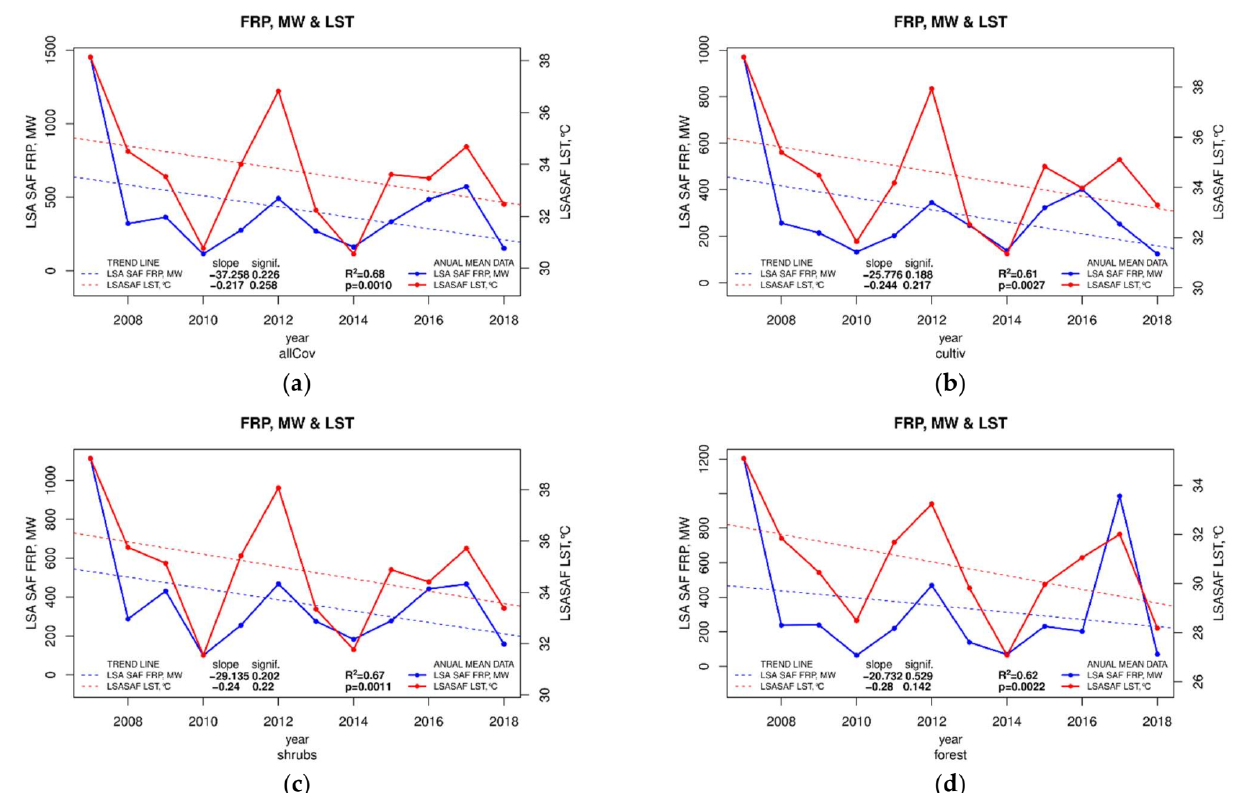
Figure 5. Time series of fire activity characterized by the total energy released from biomass burning per year FRP, MW (blue line) along with LST (red line) (June–September, 2007–2018) for: ( a ) All LC samples; ( b ) Cultivated LC; ( c ) Shrubs LC; ( d ) Forest LC. Each time series is fitted with a trend line using the linear regression technique (least squares